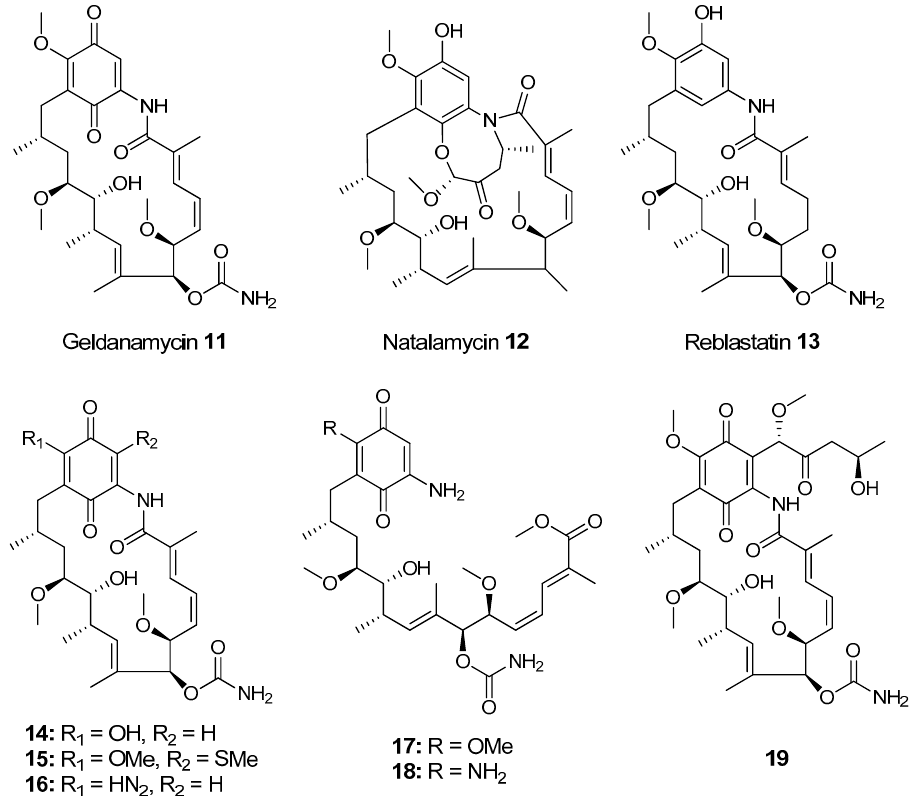
Figure 9. The known antibiotic geldanamycin and the related analogs discovered from a termite associate Streptomyces